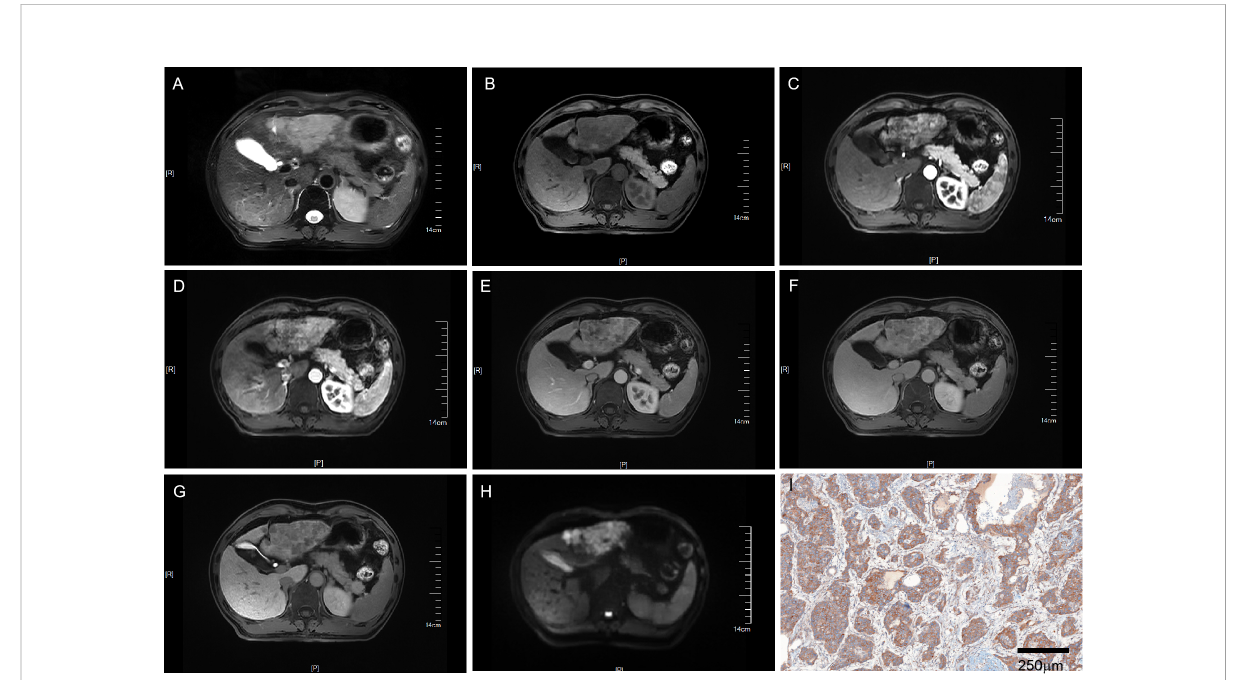
FIGURE 2 MRI of a VEGFR2-positive HCC patient with LI-RADS 5. Patient summary: a 50-year-old man with HCC in the left lobe of the liver, AFP level of 266ng/ml, lesion dimension on MRI of 8.1cm, and LI-RADS score of 5. (A) Axial T2-weighted MRI, (B) Axial T1-weighted MRI. (C, D) Early (15s) and late arterial phase (25s). (E) Portal venous phase (1min). (F) Delay phase (3min). (G) Hepatobiliary phase (15min). (H) Axial diffusion-weighted MRI. (I) VEGFR2-positivity in pathology. MRI, magnetic resonance imaging; LI-RADS, liver imaging reporting and data system; AFP, alpha- fetoprotein; VEGFR2, vascular endothelial growth factor receptor